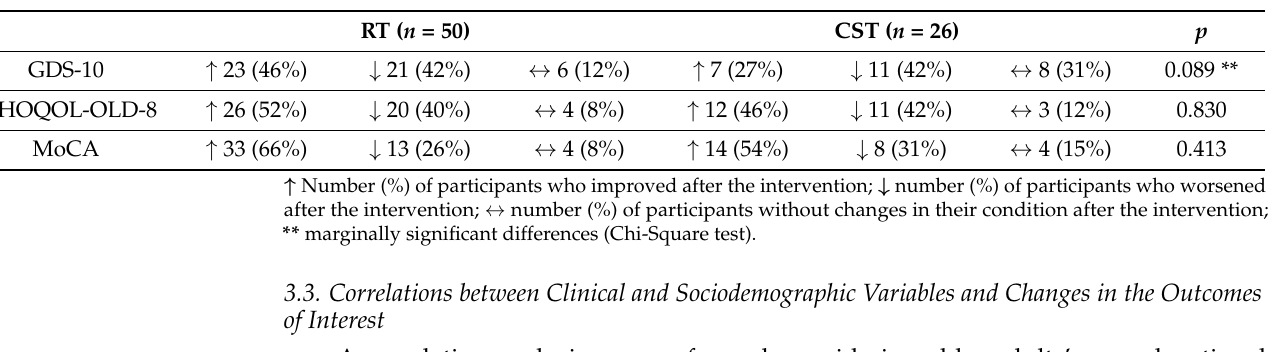
Table 3. The number of participants who improved, worsened, or maintained their clinical conditions after participating in each